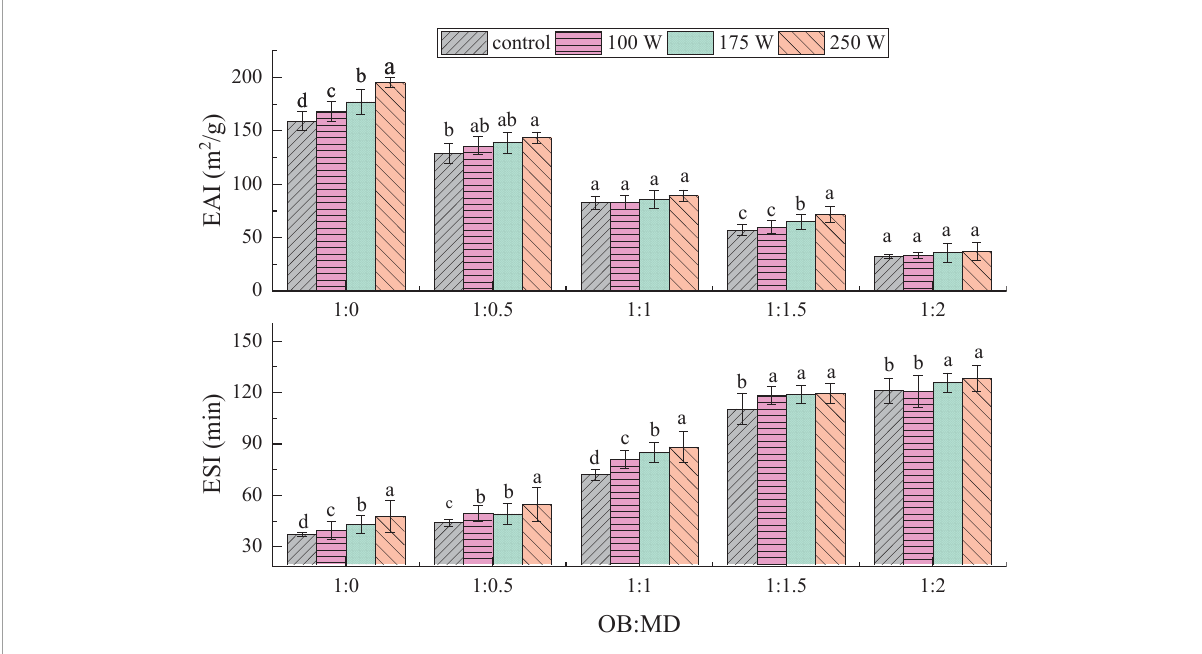
FIGURE4 Effect of dextrin addition and ultrasonic power on the emulsification activity (EAI) and emulsion stability (ESI) of OB-MD. Different letters (a–d) in the figure indicate significant differences ( P <